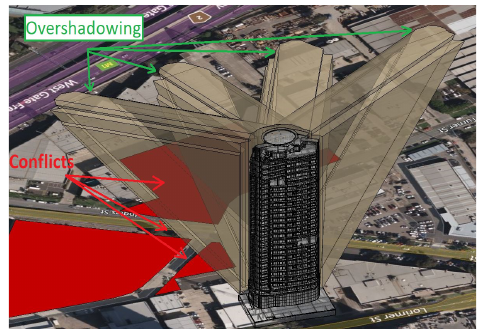
Figure 11 . Detected overshadowing conflicts against public open spaces for the four specified